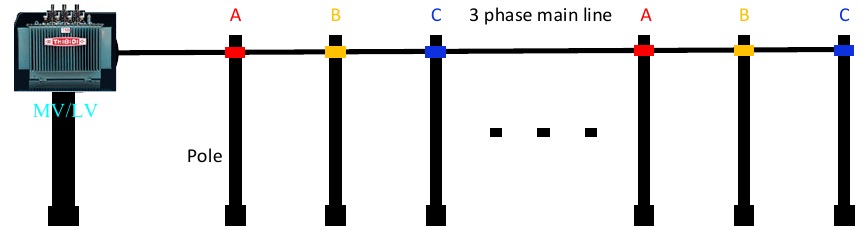
Figure 3. Repeated phase ABC (RPABC) algorithm.